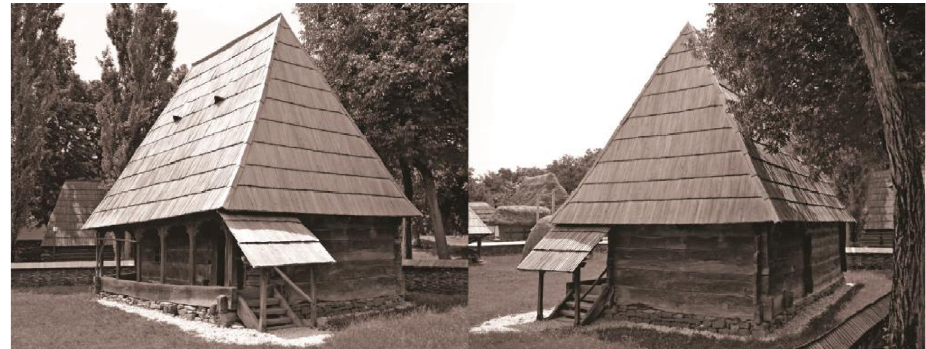
Fig. 3. A traditional house from Berbesti, Maramures, XIX-th Century (Northern Romania).